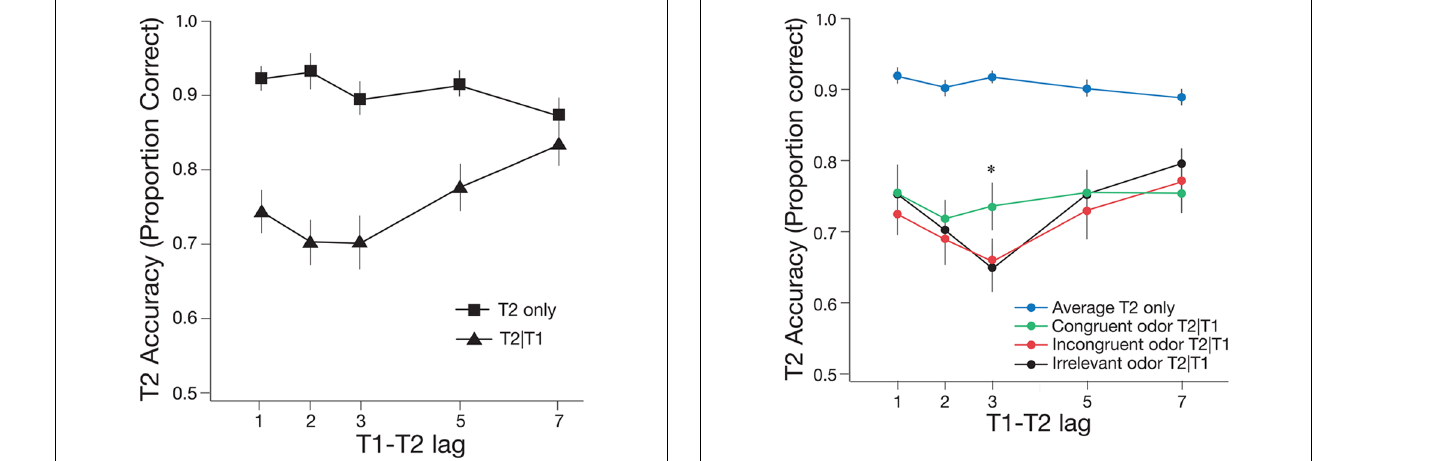
FIGURE 2 | Mean accuracy ofTarget 2 (T2) detection for single-task (T2 only) and dual task (T2|T1) plotted as a function ofT1–T2 lag for the baseline (no odor) condition. One lag corresponds with 66.6 ms. Error bars represent one standard error of the mean.